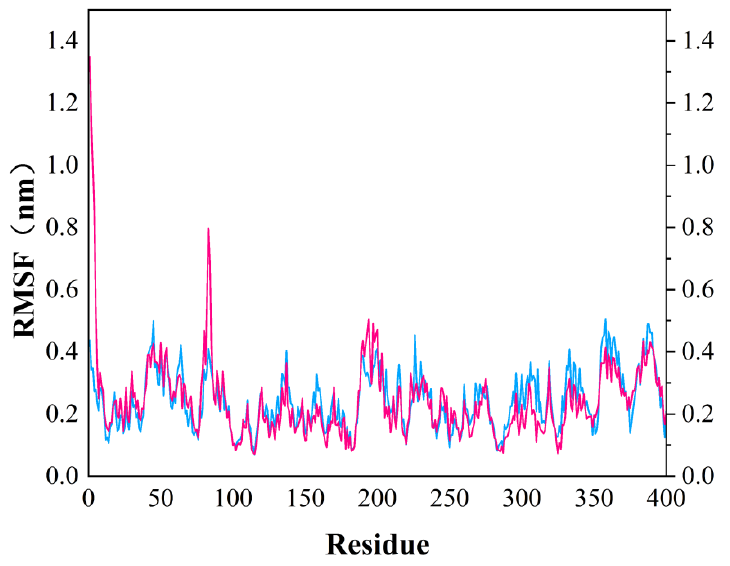
Figure 7. RMSF diagram of MurD Ligase with 46604 (magenta) and 46608 (blue) complexes.